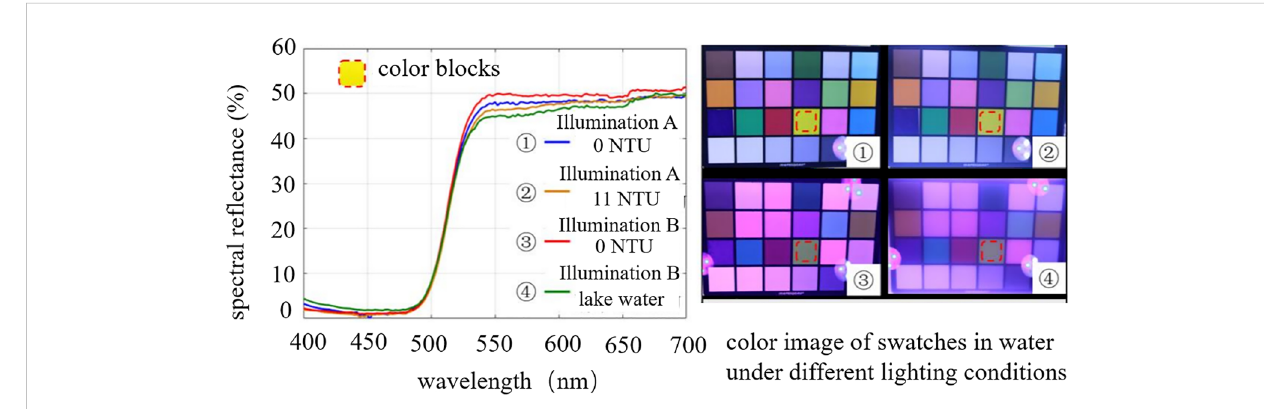
FIGURE 6 Explanation of spectral re fl ectance detection of speci fi c color block; yellow patch under varying turbidity and